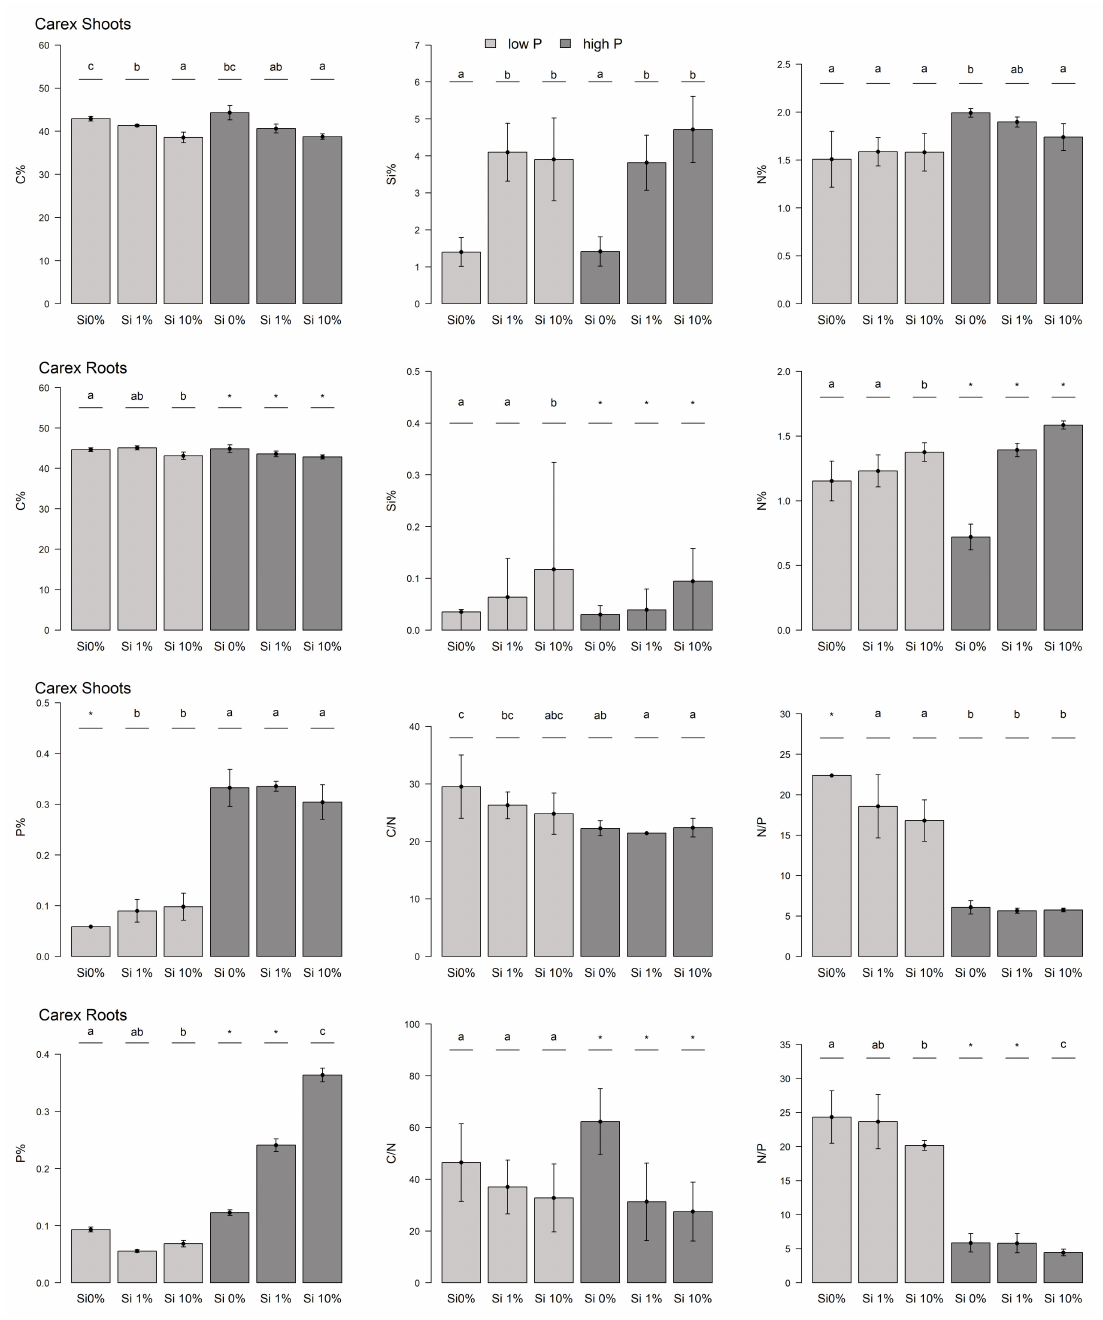
Figure A2. Carex aboveground and belowground biomass. Contents of C, Si, N as well as P and the C/N and N/P ratios are displayed. Low P fertilized plants: light gray, high P fertilized plants: dark gray. Different letters give significant differences between the treatments ( α = 0.05), those treatments that are marked with an asterisk (*) have too few data for statistical